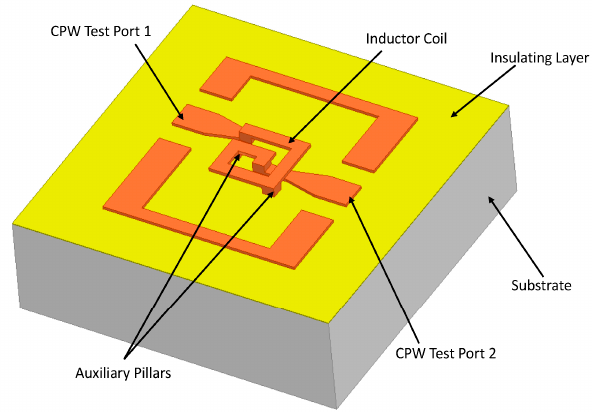
Figure 1. Schematic of the microelectromechanical systems (MEMS) suspended inductor sample.